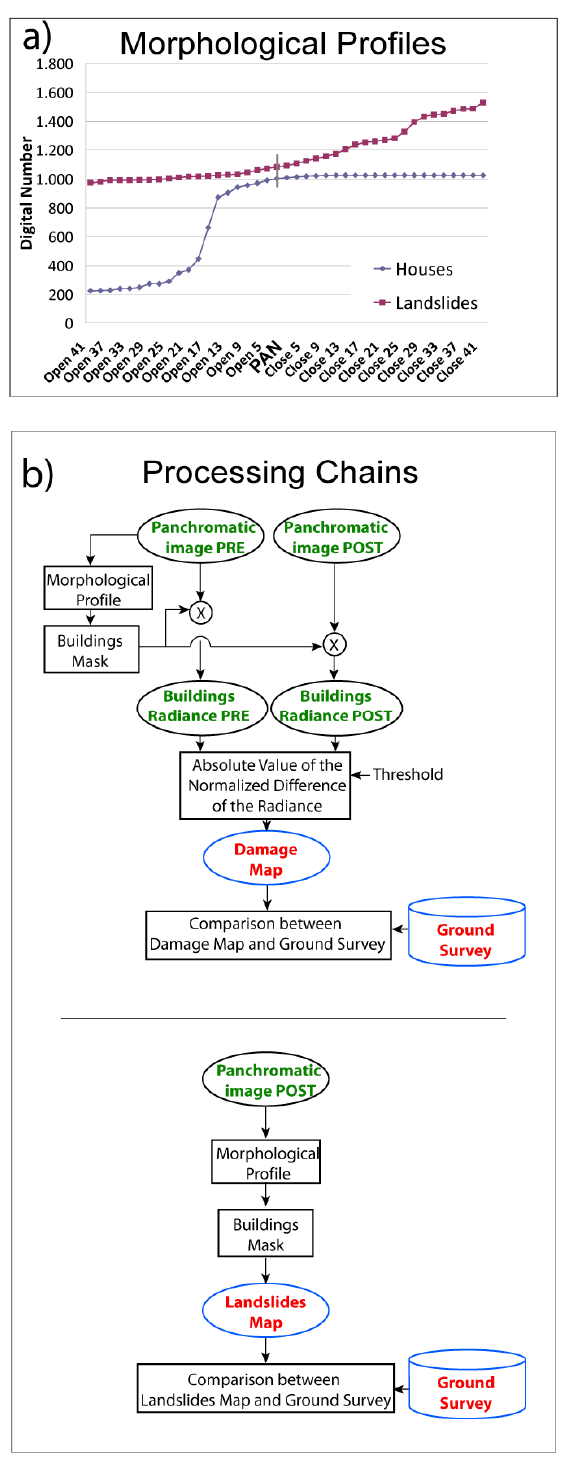
Fig. 3. (a) Morphological profiles of two classes of interest: Houses (blue) and Landslides (red). The vertical gray line in the middle in- dicates the panchromatic original image. Close to this line are small windows of morphological filters. The left part shows the output of the open operator, while the right part shows the close operator. (b) Processing Chains of the automatic algorithm for mapping damages (up) and landslides